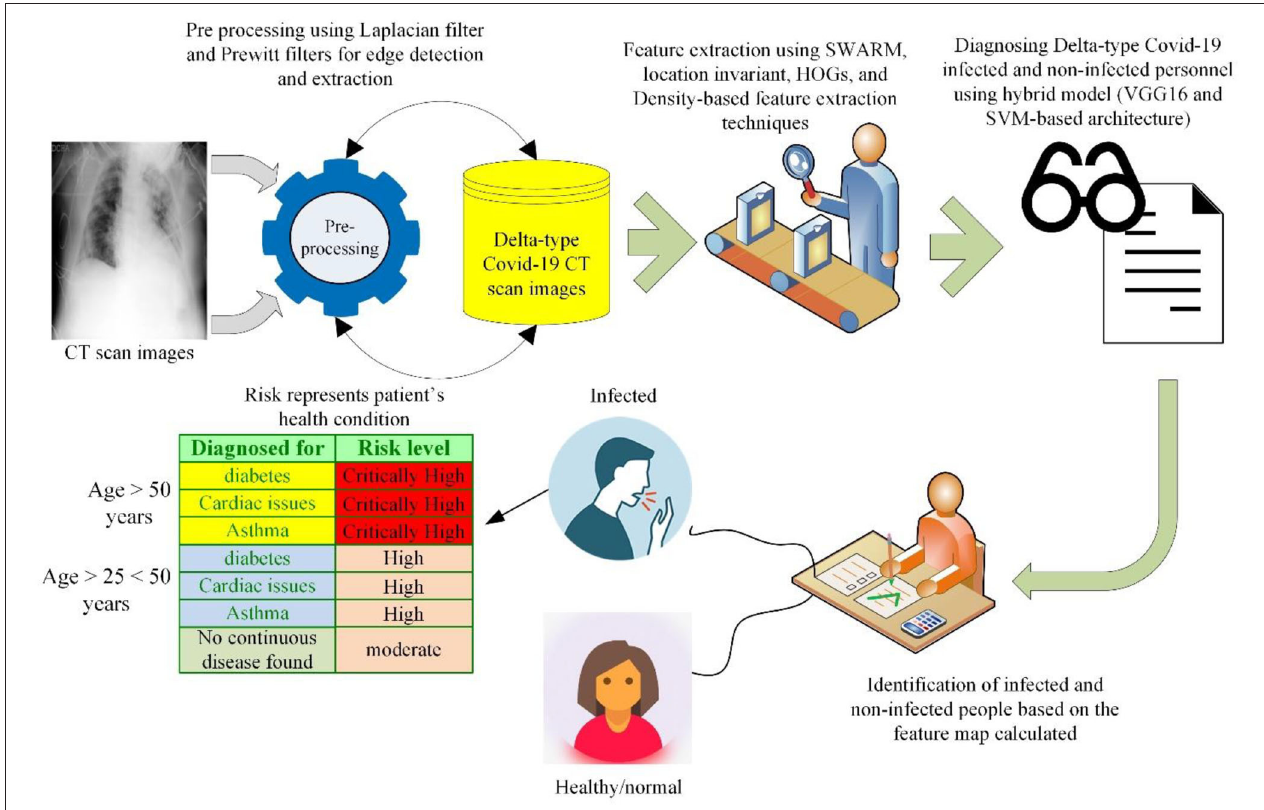
FIGURE 1 | Experimental setup of the proposed